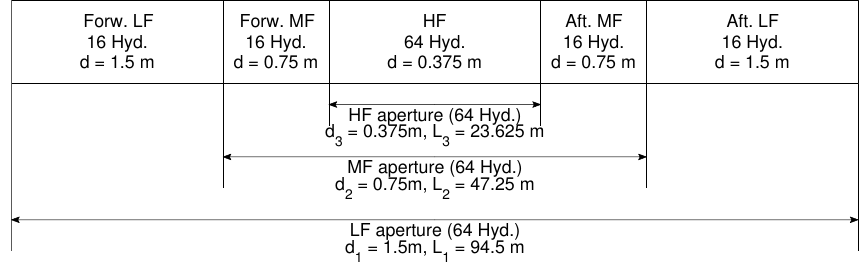
Figure 2. Schematic of three of the four subapertures of the Office of Naval Research Five Octave Research Array (ONR-FORA), including the low-frequency (LF), mid-frequency (MF) and high-frequency (HF) subapertures. The ultra-low-frequency (ULF) subaperture of the ONR-FORA is not shown